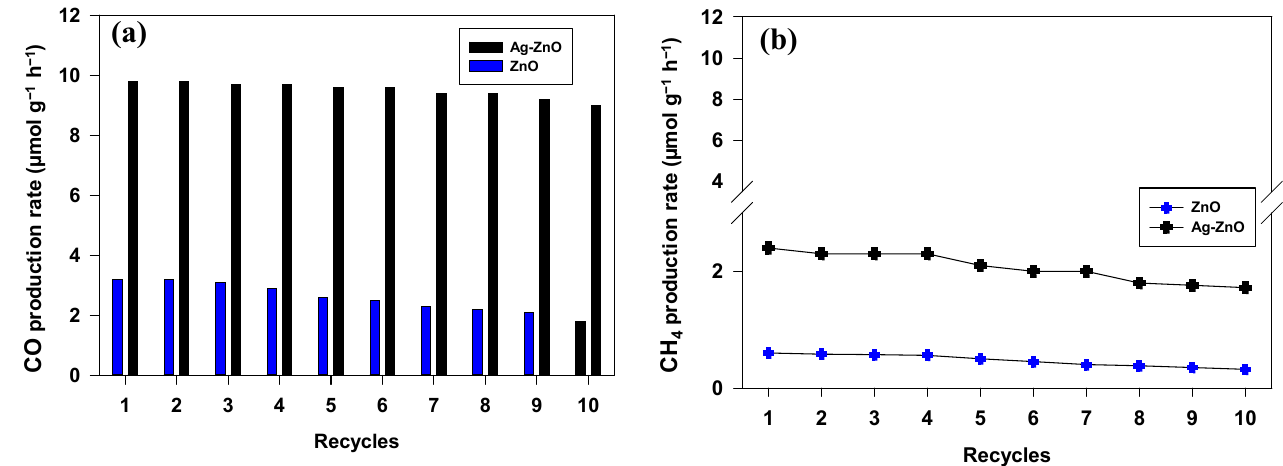
Figure 7. Recycling experiments for CO 2 conversion to ( a ) CO and ( b ) CH 4 by ZnO and Ag-ZnO. In detail, the production rates of CO and CH 4 remained at 81.3 and 72% in the 10th cycle by using Ag-ZnO. The unmodified ZnO photocatalyst displayed as a little unstable after being 10 times reused as compared to Ag-ZnO. For example, the production rate of CO after 10 recycling experiments was 58.2% and the CH 4 production rate was also rela- tively low at around 51.3%. In addition, the XRD of reused Ag-ZnO was analyzed to investigate the change in the phase structure and crystalline of the photocatalyst. The result in Figure S3 suggested that the reused Ag-ZnO photocatalyst had a similar structure and crystalline as the origi- nal material. 2.4. Proposed Mechanism Based on the collected data from characterizations of photocatalysts and experiments for CO 2 conversion, a proposed photocatalytic mechanism was proposed in Figure 8. Figure 8. Proposed mechanism for CO 2 conversion into CO and CH 4 by using Ag-ZnO photocatalyst. During the solar light irritation, the photo-induced electrons are excited from VB to CB of ZnO, producing a number of photoelectrons. The produced electrons will transfer to CB of Ag, which acts like an electron acceptor or electron conductor to increase the